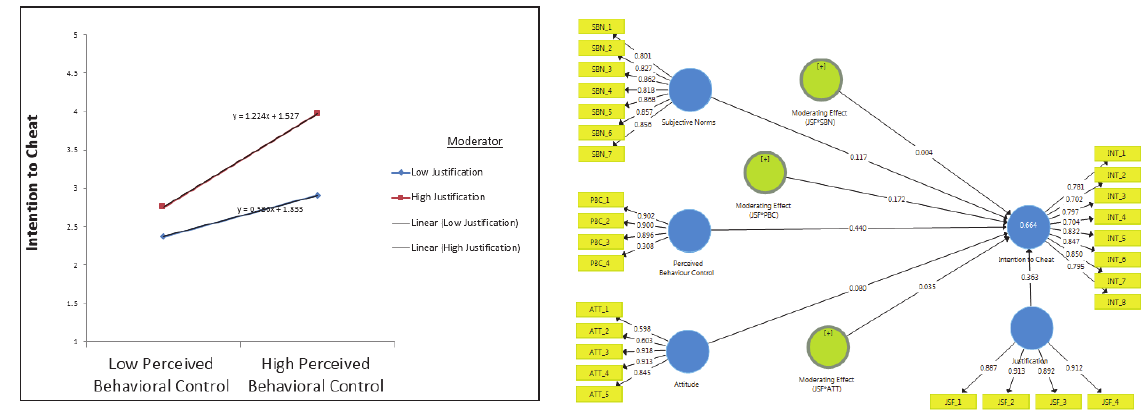
Fig. 3. Moderating effect of justification Fig. 4. PLS Algorithm result – R Square